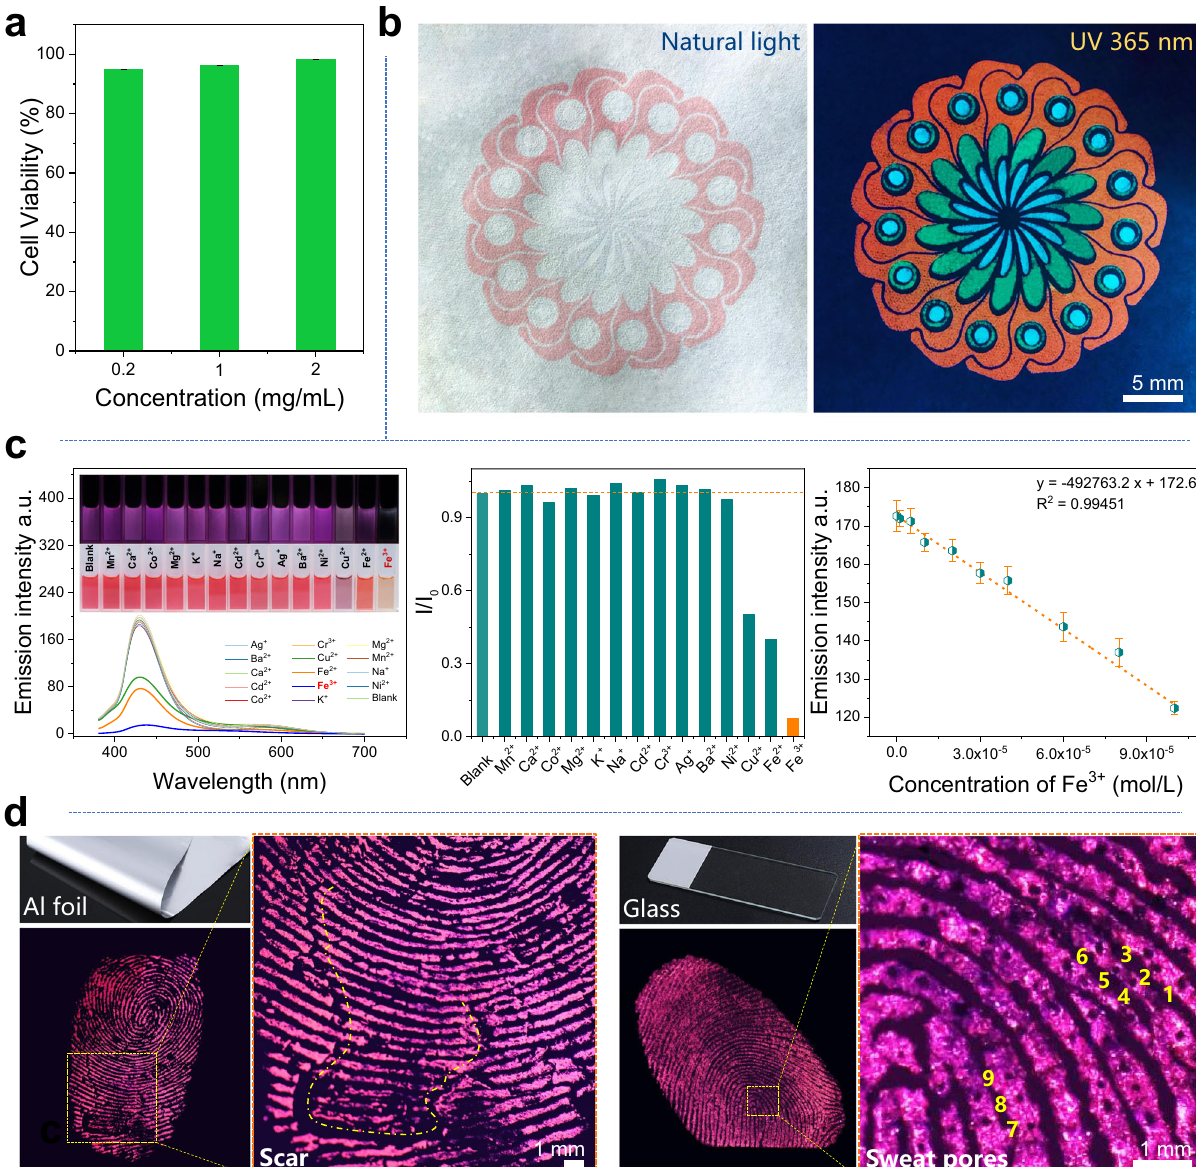
Fig. 6 Biocompatibility and applications of A-PM. a CCK-8 cell viability in the extracted liquid from A-PM-TEA powder. b Security printing by trichromic PMs inks under the natural light and UV 365 nm, respectively. c Fluorescent responses of A-PM-TEA/DMF to different metal ions and detection of Fe 3 + (excited at 365 nm), where the error bars indicate the standard deviation of the replicated tests (×3). d Forensic fi ngerprint identi fi cation on different substrates with an ultra fi ne A-PM-TEA For NaHCO 3 , the reaction solution was dialyzed (dialysis tube, 100 Da) to remove the unreacted monomers and initiator fi rst and then the solid sample was obtained by freeze-drying. For the reaction solution with HA, solid powder was recovered by directly precipitating the reaction solution in water (washed with ethanol for three times and dried in a vacuum at 80 °C), The product yield for different A-PMs is listed in Supplementary Table 5. Synthesis of Fr-PM . Maleimide (6.07 g) was dissolved in 10 mL of DMF and AIBN (0.02 g) was added as initiator of free-radical polymerization. The solution was stirred in a nitrogen atmosphere for 30 min to remove oxygen and then heated to 60°C and stirred for 24 h. Finally, the solution was precipitated in ethanol. The fi ltered precipitate was washed with ethanol for three times and then dried in vacuum at 80 °C to obtain white powders (yield = 72 %). Pressure-dependent fl uorescence of A-PM . In total, 2.0g of A-PM-TEA powder was dissolved in 5.0mL of DMF. The solvent was slowly evaporated on a hot plate